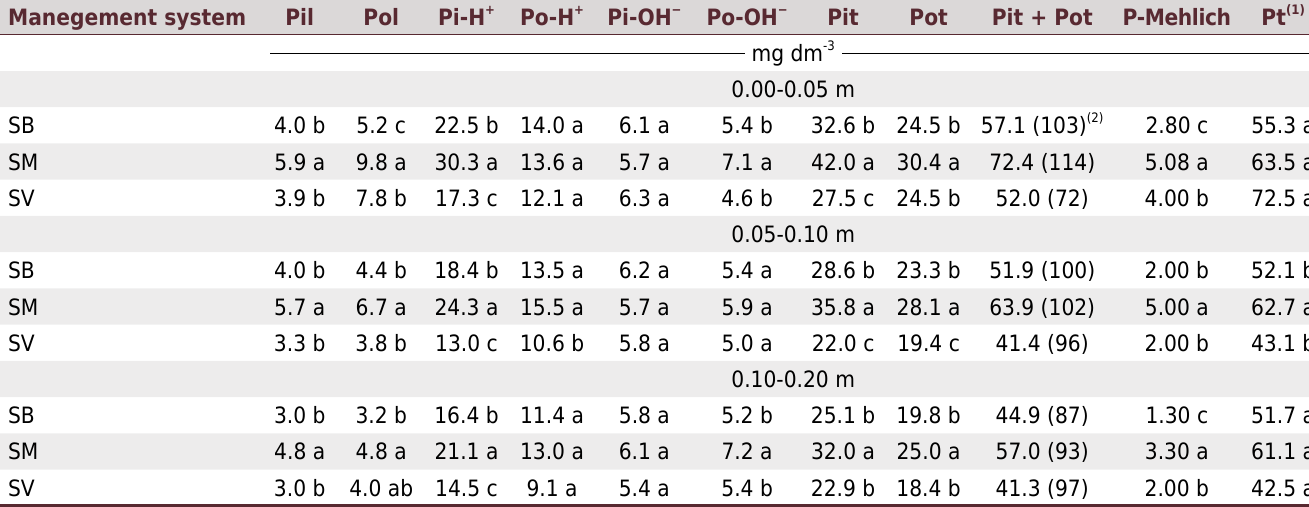
Table 2. Contents of fractions of P in an Argissolo Amarelo Distrófico (Ultisol) under slash-and-burn (SB), slash-and-mulch (SM) and secondary vegetation (SV) systems at different depths Manegement